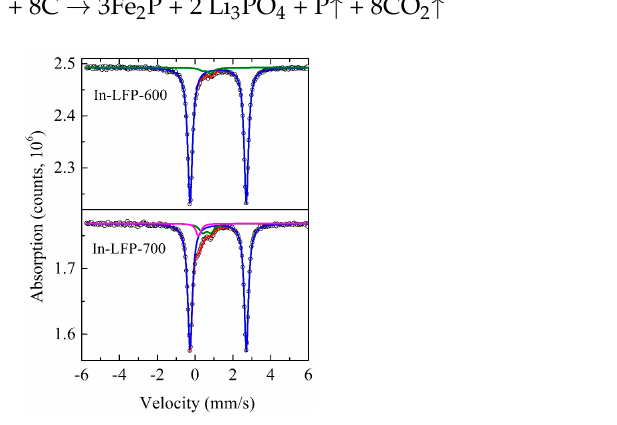
Figure 3. XPS spectra of Fe of In-LFP-600 and In-LFP-700 samples.